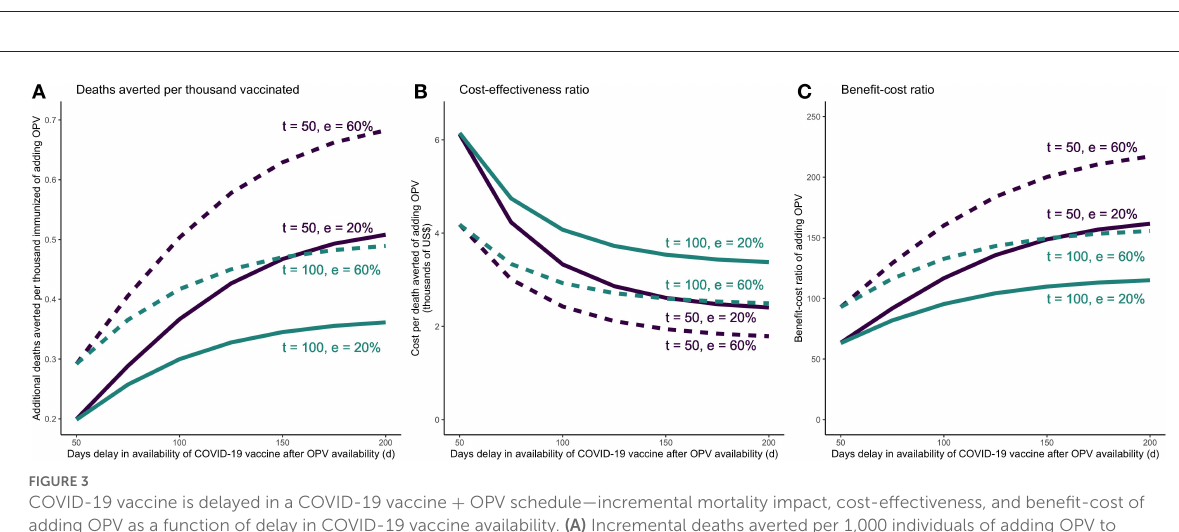
FIGURE3 COVID-19 vaccine is delayed in a COVID-19 vaccine + OPV schedule—incremental mortality impact, cost-effectiveness, and benefit-cost of adding OPV as a function of delay in COVID-19 vaccine availability. (A) Incremental deaths averted per 1,000 individuals of adding OPV to COVID-19 vaccine only schedule. (B) Incremental cost-effectiveness ratio per averted death of adding OPV to COVID-19 vaccine only schedule. (C) Incremental benefit-cost ratio of adding OPV to COVID-19 vaccine only schedule. The results reflect the scenario in which vaccine coverage for both vaccines are set at 30%. OPV is administered on day t , and the COVID-19 vaccine is administered d days after OPV. The COVID-19 vaccine is assumed to be 74% effective against infections and reducing infectivity, 95% effective against severity, and require 28 days from administration until the it becomes fully effective. e = effectiveness of OPV vaccine against